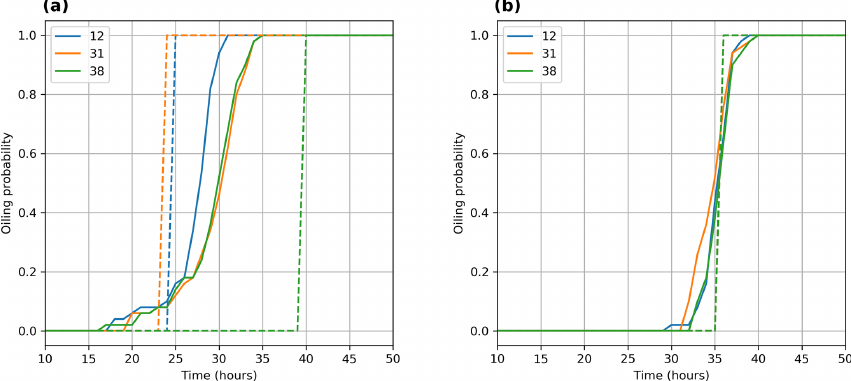
Figure 12. Oiling probability P (no units) for (a) winter and (b) spring as a function of the forecast time. Different colors denote oil spill types API 12, 31, and 38. Dashed lines represent the deterministic state and solid lines represent the ensemble.